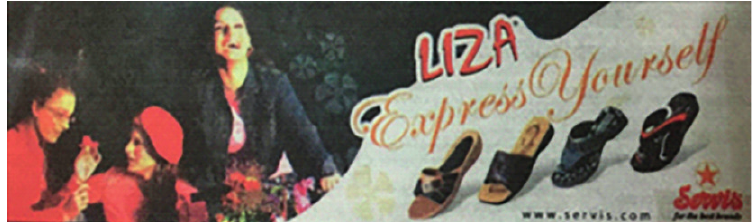
Figure 2. Advert of joggers Liza by service (source: The Nation,